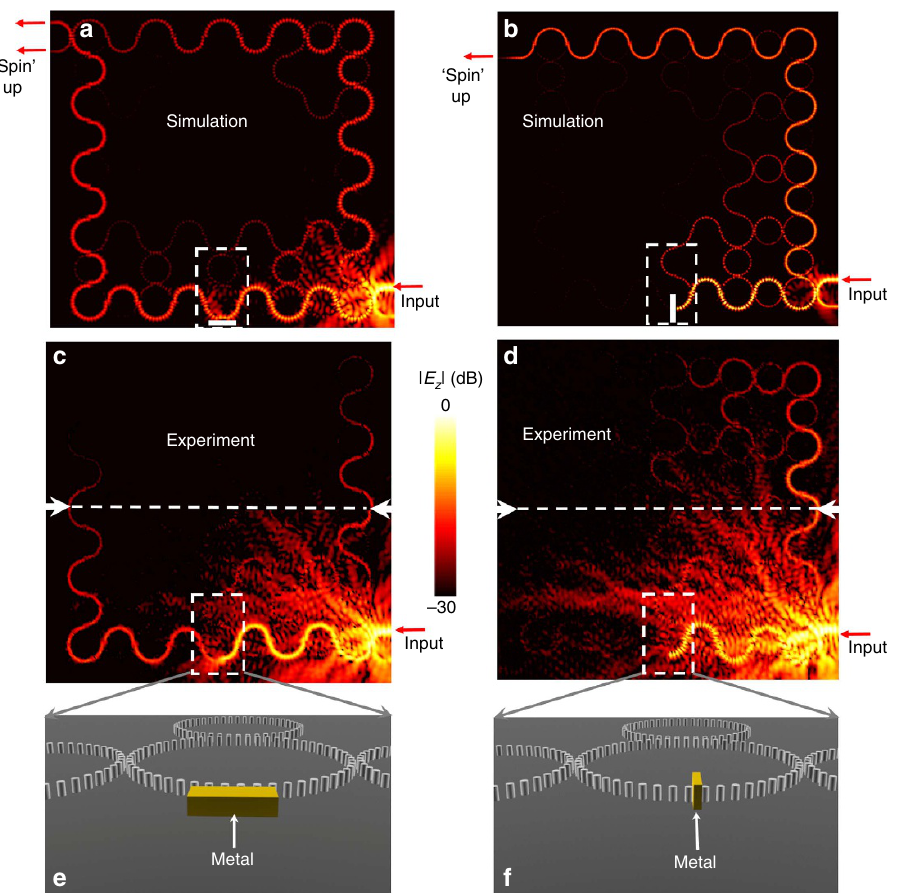
Figure 7 | Demonstration of time-reversal-invariant ‘spin’ flipping defect. Simulated ( a ) and observed ( c ) field pattern when a metallic block (shown in e ) is located near a lattice ring without touching. Simulated ( b ) and observed ( d ) field pattern when the metallic block (shown in f ) is inserted in a lattice ring. Metal is modelled as a perfect electric conductor in simulation. The dashed rectangles show the positions of defects. The dashed lines denote positions of transmission